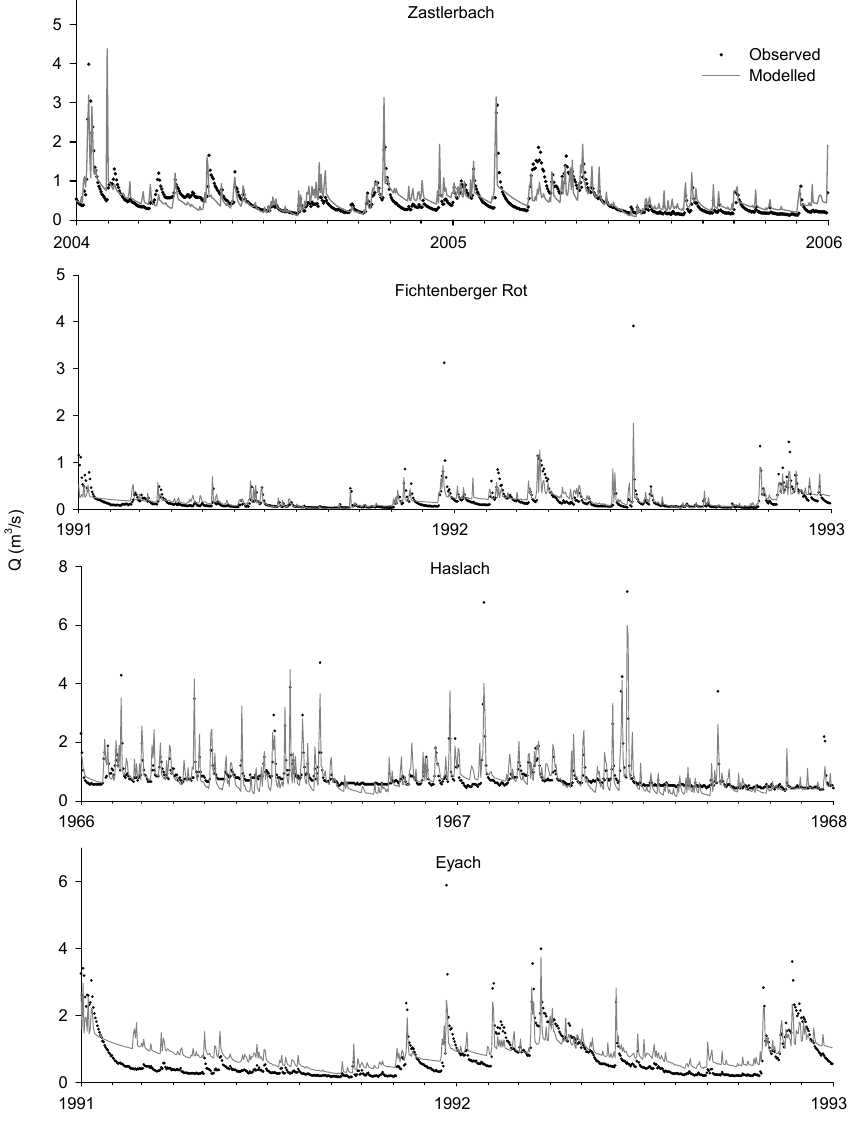
Fig. 5. Modelled and observed hydrographs of the four Figure 5. Modelled and observed hydrographs of the four catchments. 3